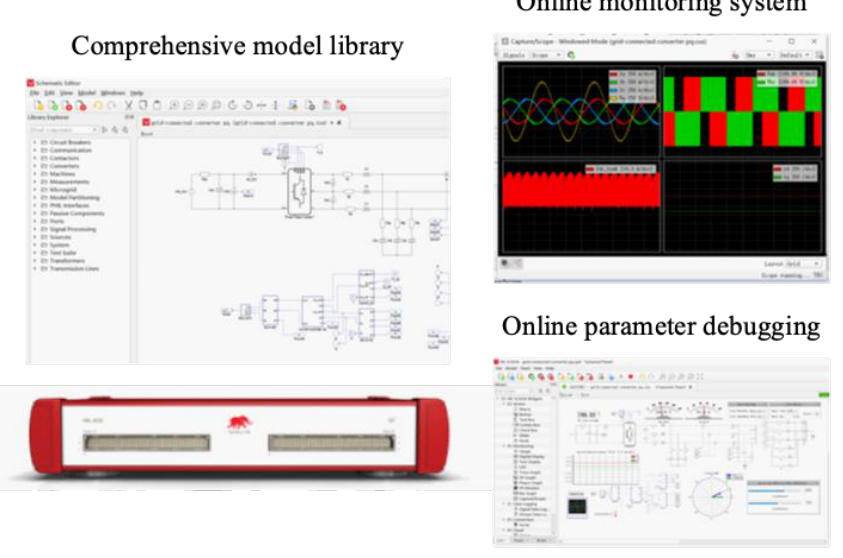
Figure 2. Typhoon Figure 2. Typhoon HIL402.